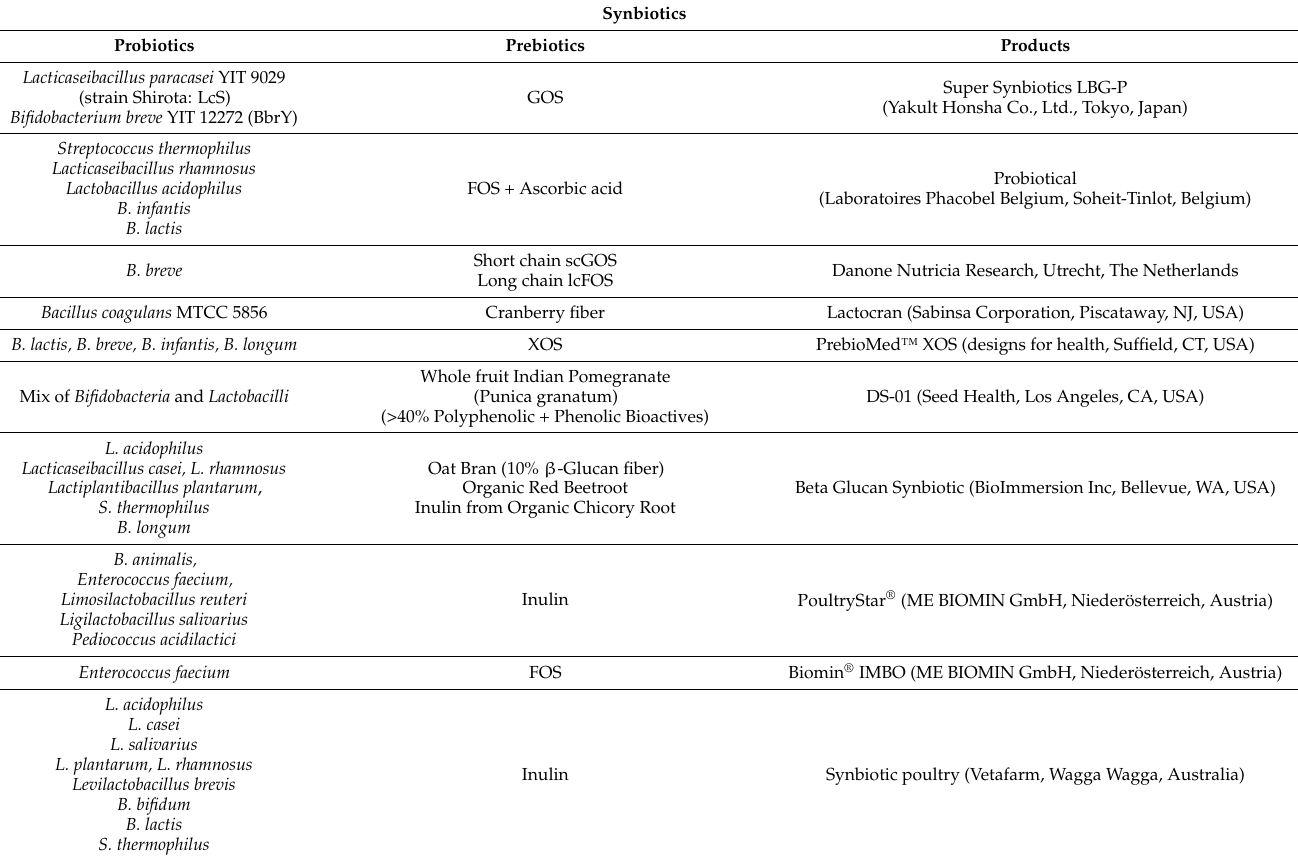
Table 1. Some examples of synbiotics, their probiotic and prebiotic components, and trade names.